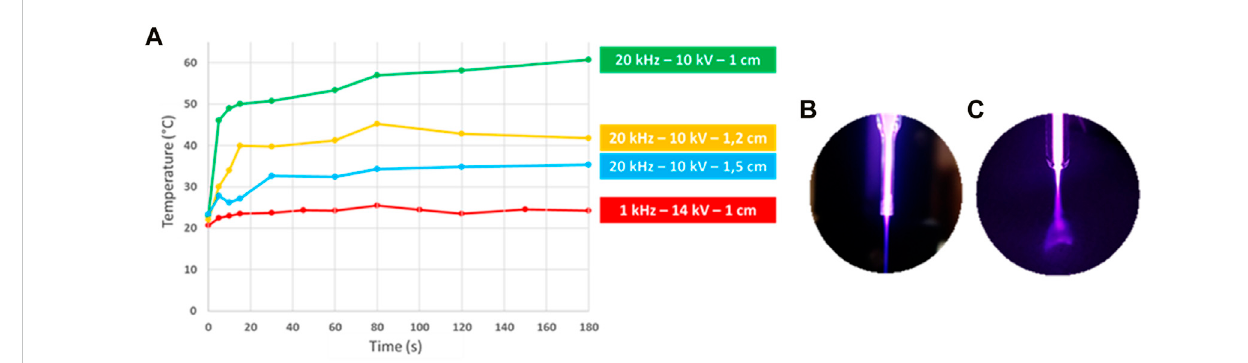
FIGURE 3 (A) Explant surface temperature evolution during 3 minutes for different plasma jet regimes. (B) and (C) are photographs of the plasma plume impinging on explant surface for 1 kHz, respectively, 20 kHz, pulse repetition